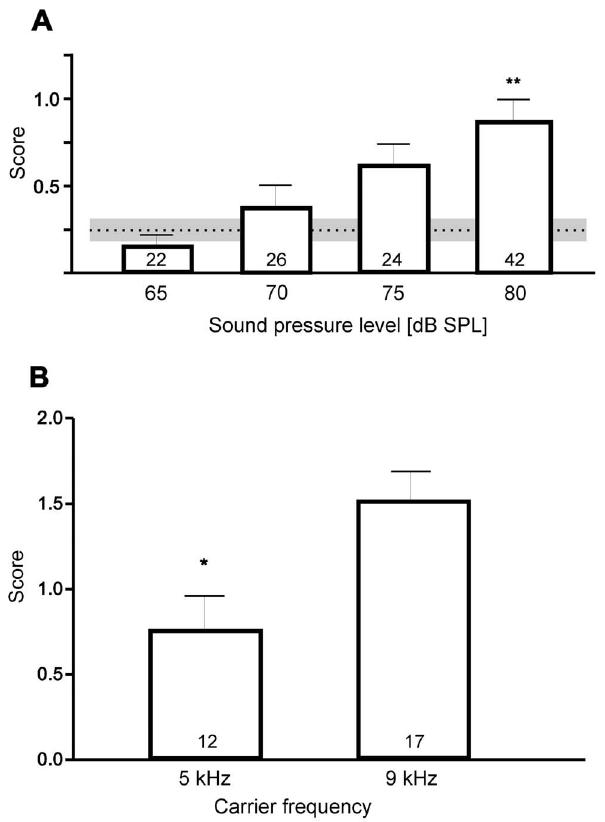
Figure 3. Phonotactic behaviour of male E. auditrix . The behaviour was scored in three classes, which were assigned one point each. Class 1: turning towards the speaker, class 2: moving towards the speaker (20 cm), class 3: complete phonotaxis and reaching the speaker (in 50 cm distance). A Phonotactic score in respect to the sound pressure level of the calling song. The dashed line indicates the score without sound; the grey area indicates the variation ( + - s.e.m.). The numbers of tests are indicated in the columns. Each animal was tested twice (N=12, n=24 without sound; N=11, n=22 for 65 dB SPL; N=13, n=26 for 70 dB SPL; N=12, n=24 for 75 dB SPL), except for 80 dB SPL (N=14, n=42). Mean with s.e.m., ANOVA with Bonferroni correction. B Phonotactic score in respect to song models with different carrier frequencies (both at 80 dB SPL). Despite the more sensitive hearing at 5 kHz, the phonotactic score to 5 kHz models is significantly lower than to 9 kHz models (p=0.0113, t=3.27, df= 11, paired t-test). The numbers of tests are given in the columns; each animal was tested once. Mean with s.e.m.